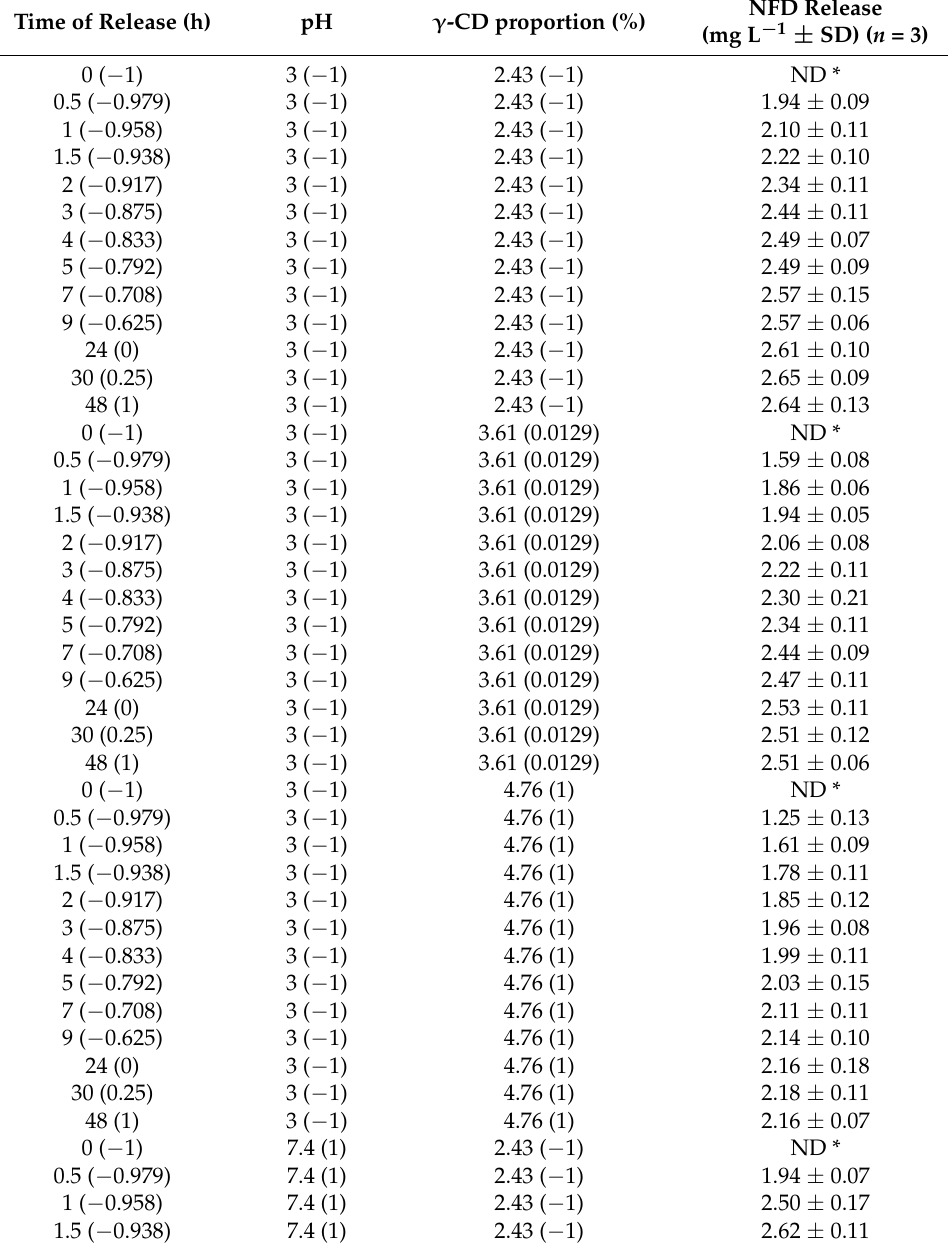
Table 5. Experimental design matrix. The values between parenthesis are the codified